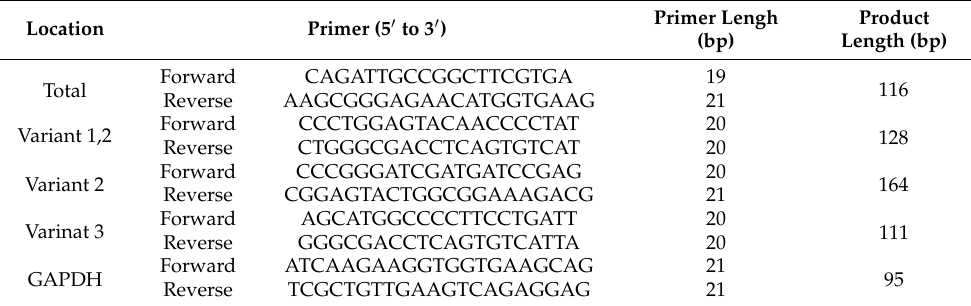
Table 1. Oligonucleotide primers for real-time PCR of Cathepsin A variants and